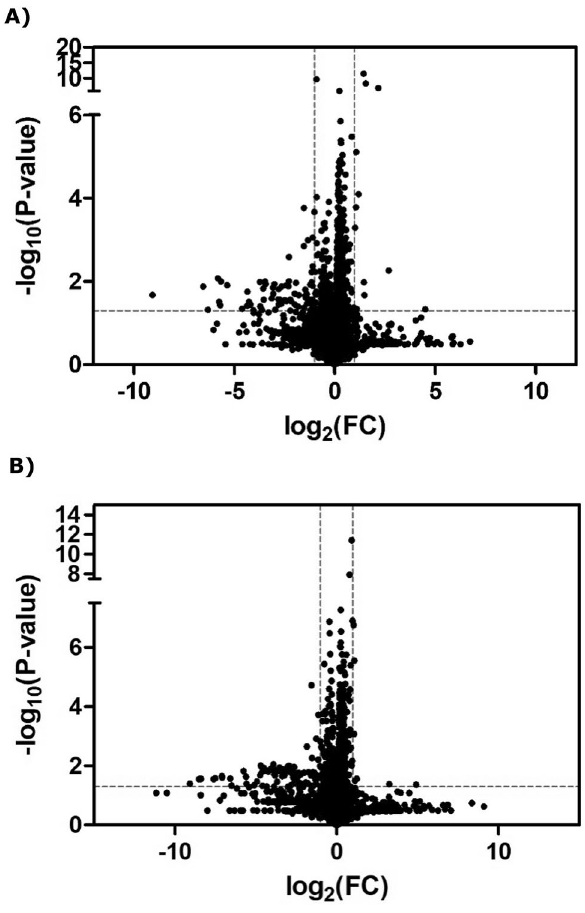
Figure 2. Volcano plot of differential abundance of metabolites found in metabolomics assay of NC-AME versus control subjects. The X-axis is the Log2 of metabolites levels (fold change) between subjects with NC-AME and control subjects. The Y-axis shows the − Log10( p value) obtained from comparison of control versus NCAME group by an unpaired student’s t test. The range of Y > 1.30 (equal to p value of 0.05) and X > 1 were considered as significant increase; The range of Y > 1.30 and X < 1 were considered as significant decrease. ( A ) At negative ion mode ( B ) At positive ion